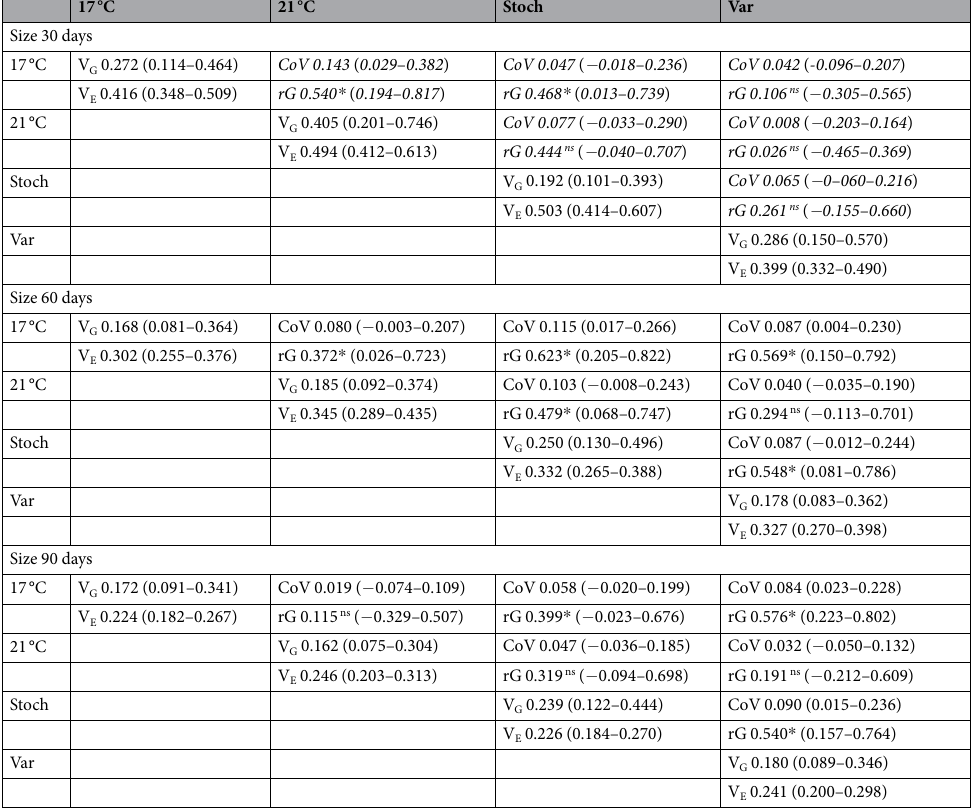
Table 3. Genetic variance-covariance matrices for stickleback ( Gasterosteus aculeatus ) offspring body size (standard length) at 30, 60 and 90 d post-hatch analysed by multivariate animal models taking temperature- specific size (character states) at 17°C, 21 °C, stochastic (Stoch), and variable (Var) offspring rearing environments as response variables. Elements on the diagonal give estimated genetic (V G ) and environmental (V E ) variance components with 95% CI. Off-diagonal elements give genetic covariances (CoV) and genetic correlations (rG) between character states. Significance of genetic correlations was tested as the proportion of posterior values overlapping zero. * P < 0.05; ns = not